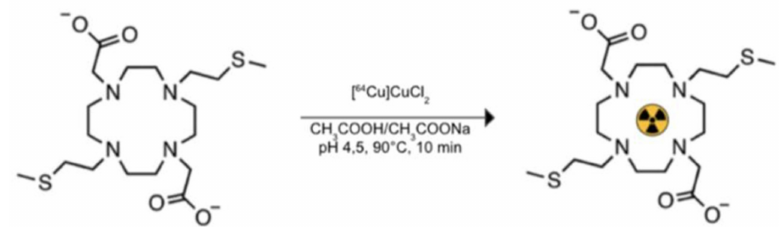
Figure 3. Labeling reaction through 64